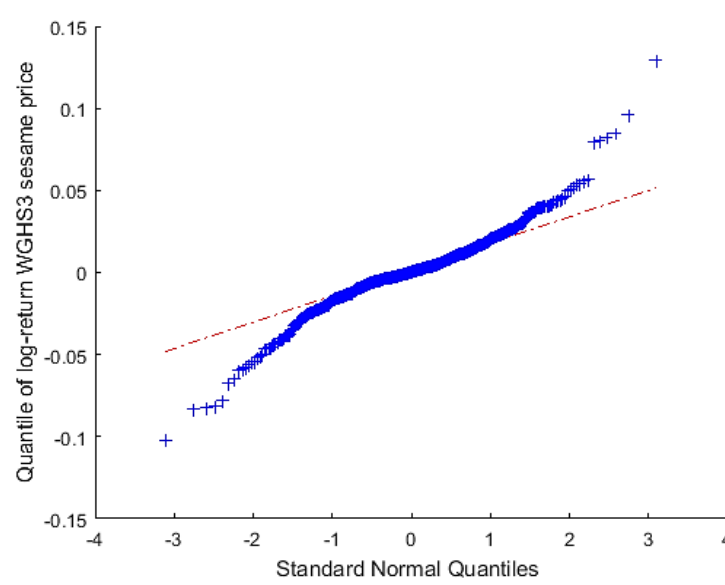
Figure 4. The Q-Q plot of log-return WHGS3 price from 2010-2018.